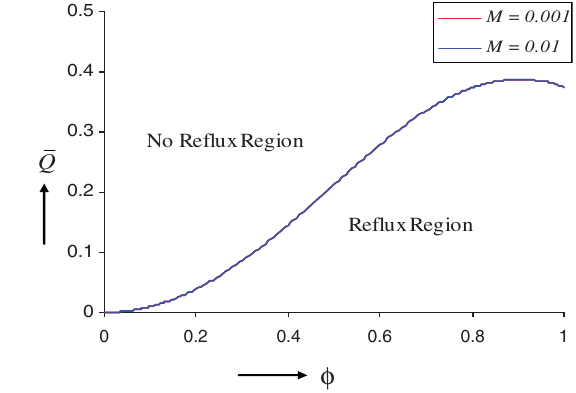
Fig.10. Mechanicalefficiencyvs.ratioofaverageflowratetomaxi- mumaverageflowrate,basedonEq.(33),curvesrepresentefficiency of peristaltic pump for N =0.0, 0.9, φ =0.4 and M =1.0.